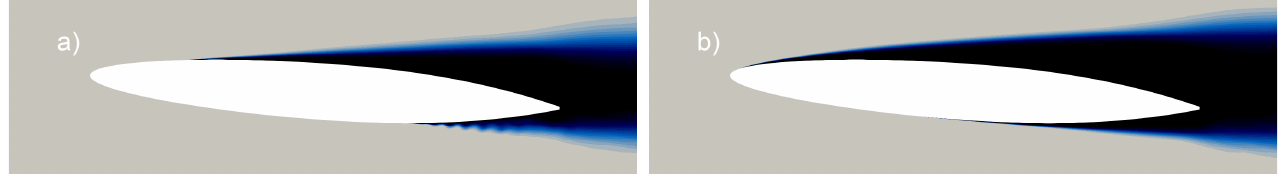
Figure 12. Sheet cavitation development history of NACA16012, AoA = 3 ◦ , Re = 1,000,000, σ = 0.045. ( a – c ) bridged model at T = 0.001 s, 0.1 s and 0.3 s. ( d ) unbridged k − ω SST + SS at T = 0.3 s.